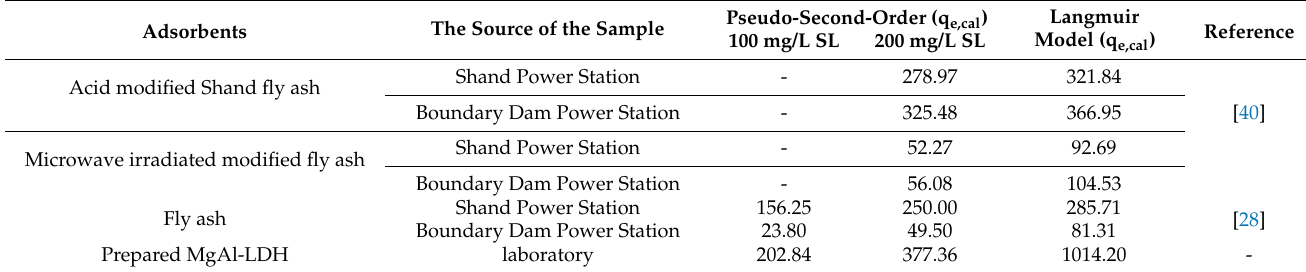
Table 5. Comparison of the adsorption performance of different adsorbents on sulfonated lignite.